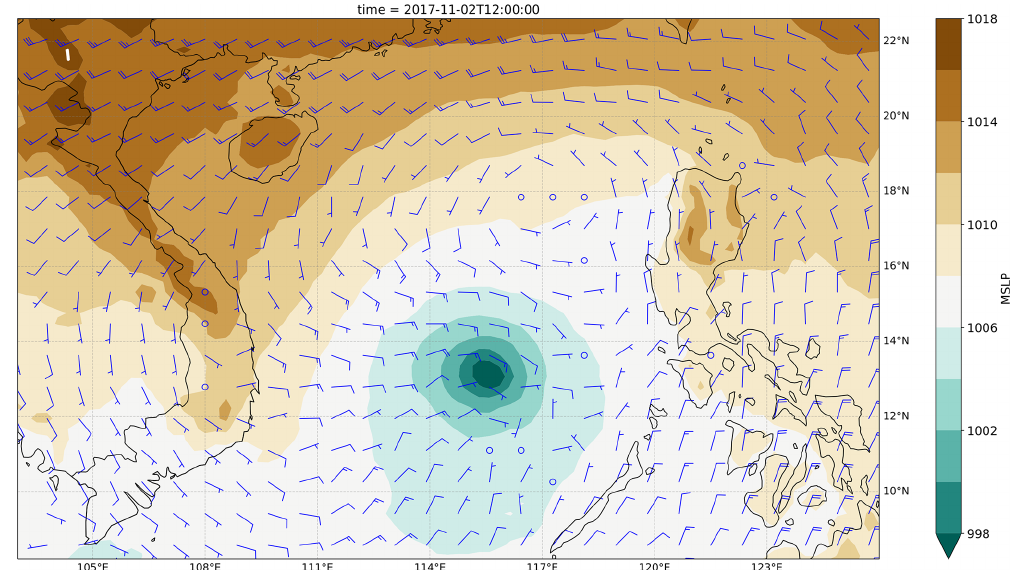
Figure C1. Ensemble mean initial state for MSLP (coloured contours) and 200hPa wind vectors (blue barbs) at a T L 639 resolution on 2 November at